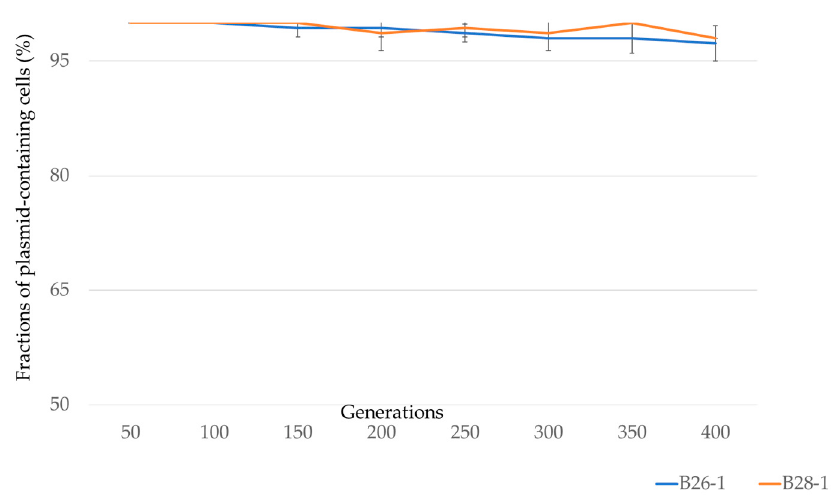
Figure 3. Stability of pTsB26 in B26 and B28.